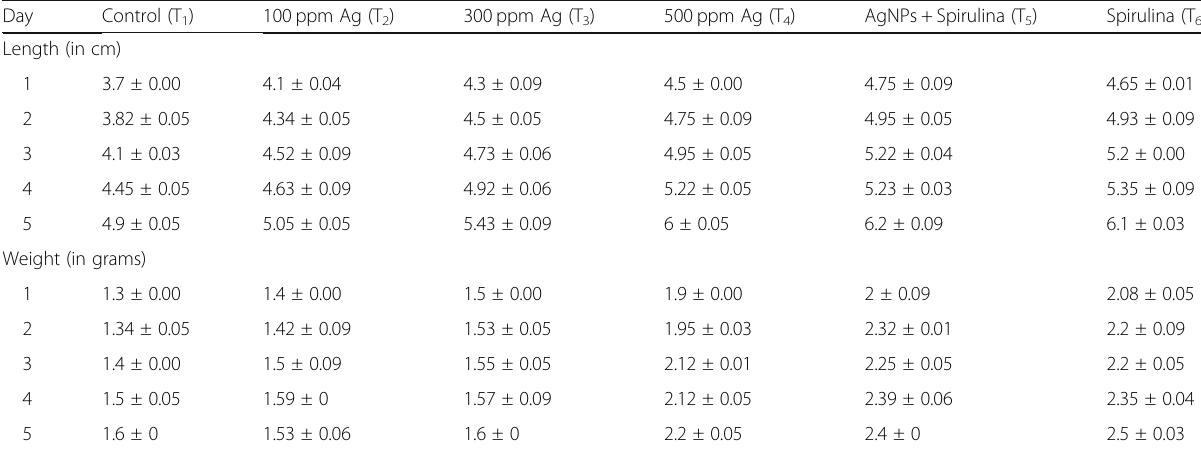
Table 2 Growth rate of the fifth-instar larvae of silkworm